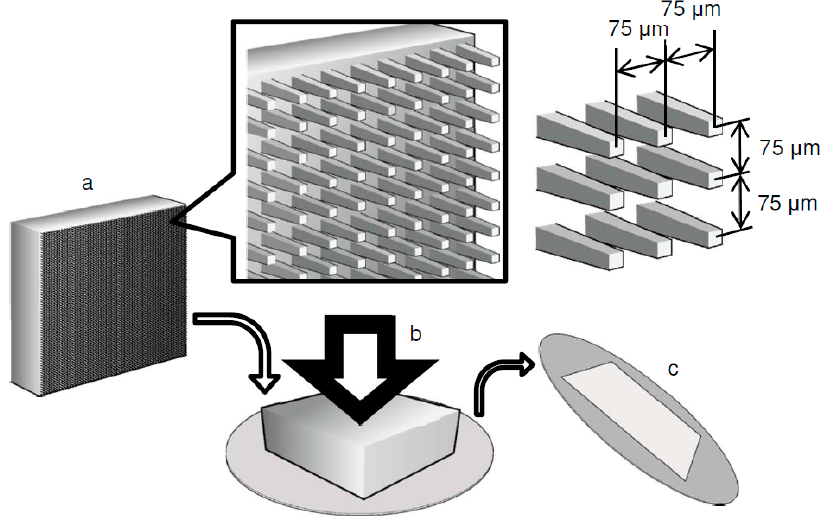
Figure 1. The fabrication process of the microperforated titanium (Ti) membrane: ( a ) Frog pin-type microarrayed pin needle punch (MPNP) was prepared with unified square needles evenly arrayed in 75 μ m intervals. ( b ) The MPNP punched the Ti sheet with a servo press (1500 kg/cm 2 ). ( c ) Ti membranes were formed with a precise array of 17,700 holes in a 10 × 10 mm area.